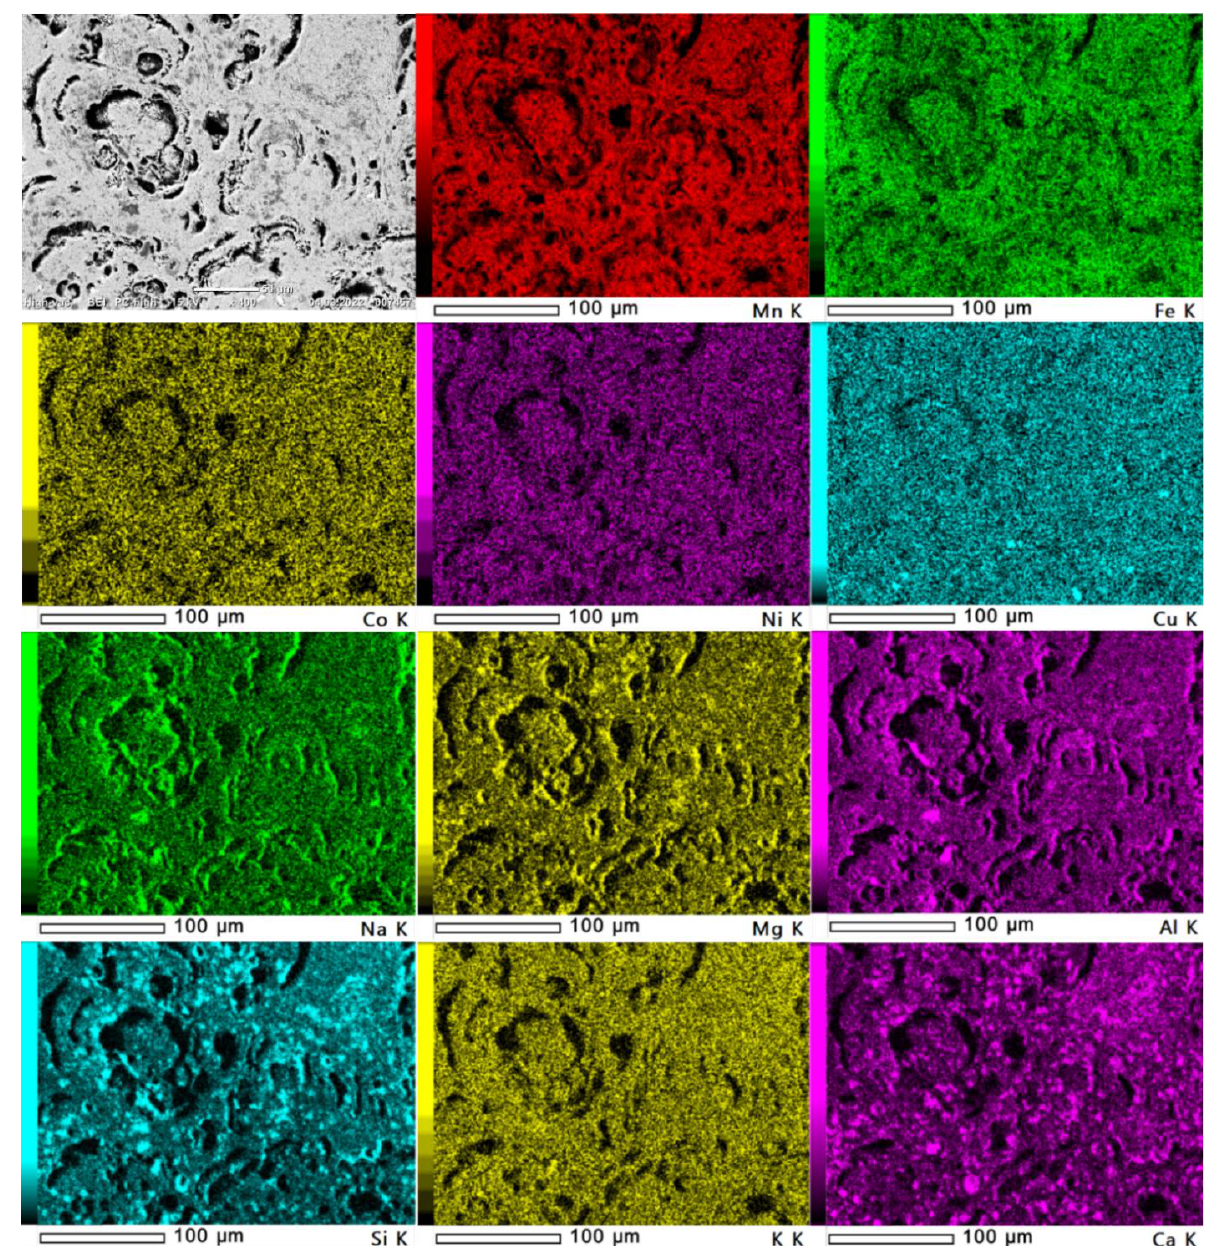
Figure 9. SEM-BEI image of the calcined ore and elemental distribution mapping by EDS of the same area.